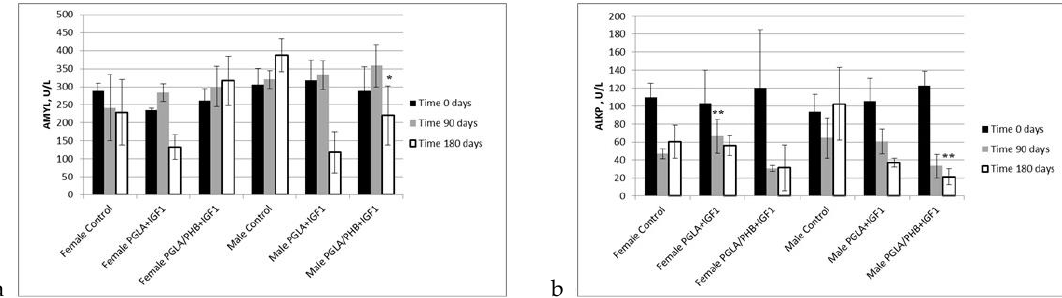
Figure 14. Amylase (AMYL) concentration ( a ) and alkali phosphatase (ALKP) activate ( b ) in blood of rabbits. * statistically significant differences at p < 0.05, ** statistically significant differences at p < 0.01.